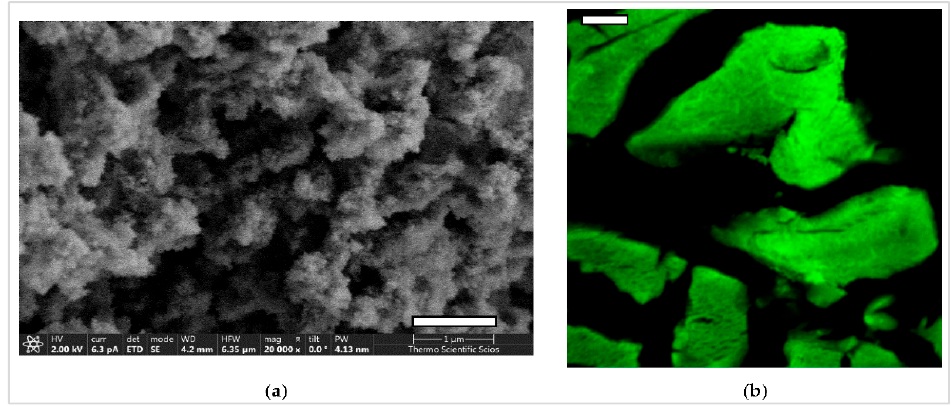
Figure 6. ( a ) SEM image of silica–gelatin aerogel hybrid and ( b ) fluorescence images of paraffin- encapsulated aerogel particles [81].